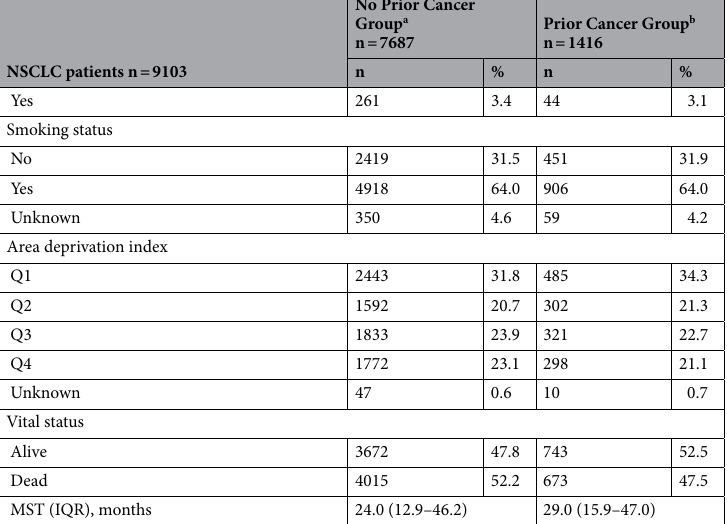
Ref. Ref. Ref. Ref.